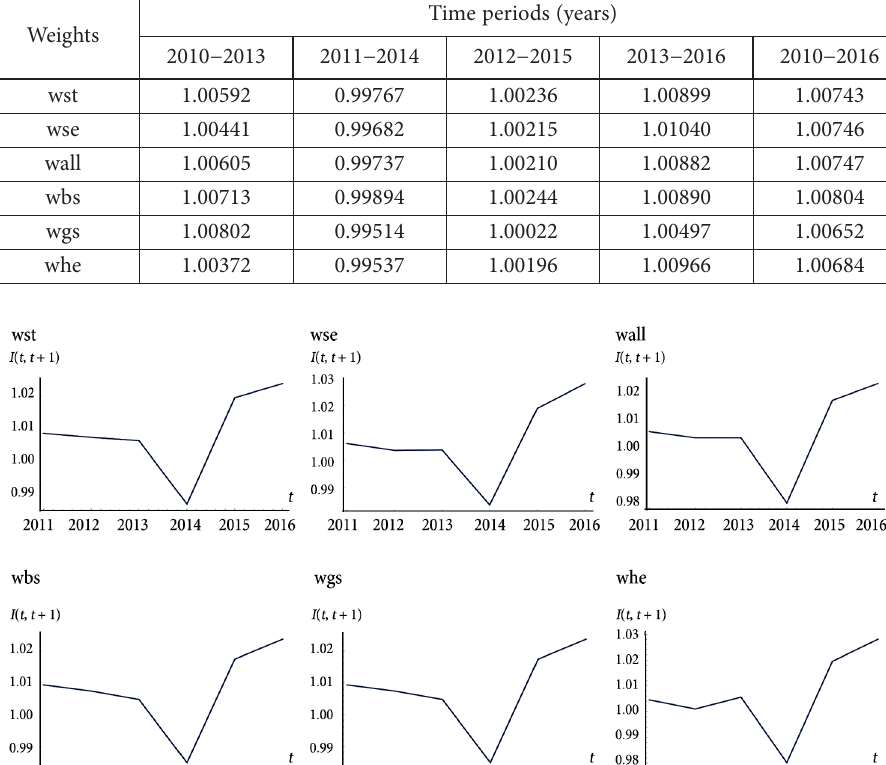
Table 5. The average innovativeness change ( , ) I s t calculated for the EU-15 (source: own elaboration based on the data of the European Statistical Office – Eurostat and European Commission, 2018. Eu- ropean Innovation Scoreboard 2018)